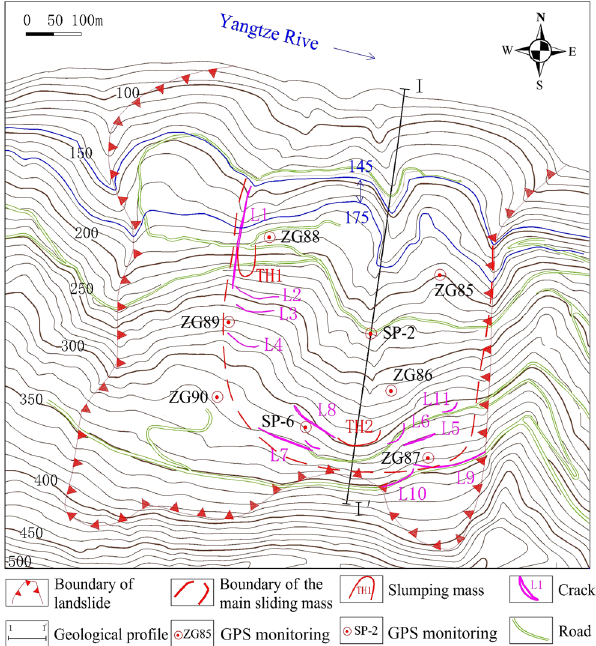
Figure 2. Topographical map of the Shuping landslide, with the location of the monitoring networks (Drawn by Ying Cao using AutoCAD 2014, https://www.autodesk.com.cn/), the cross-section can be seen in Fig. 3.